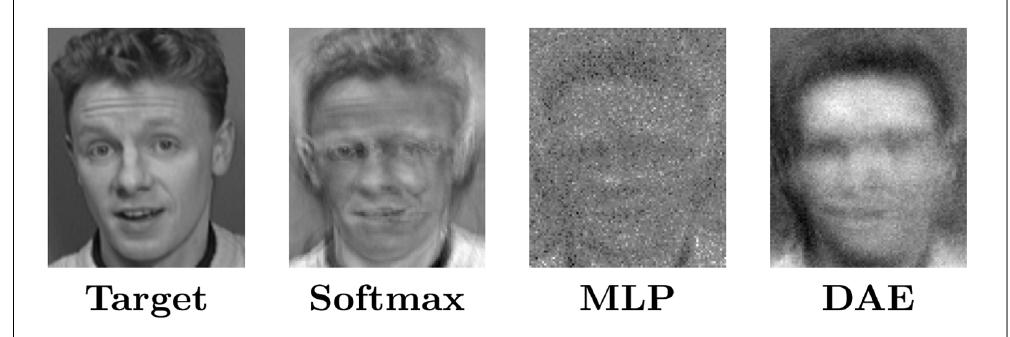
Figure 5. The reconstruction results of model inversion attacks (Image Credit: Fredrikson et al.